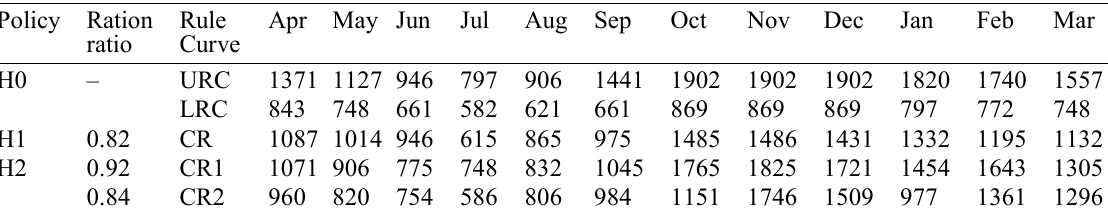
Table 1 Ordinates(Mm 3 ) of tested rule curves and operating policies